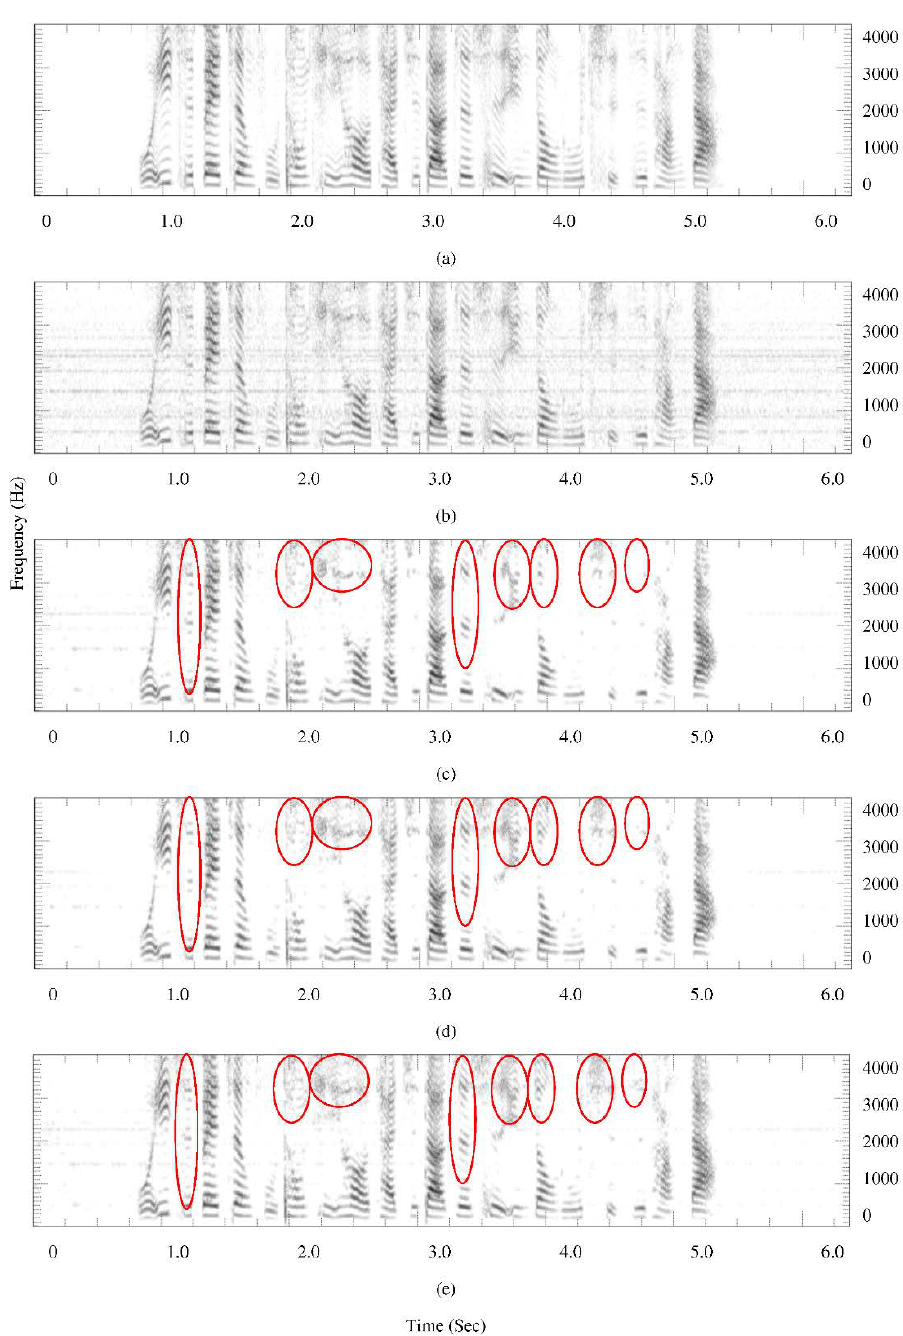
15 of 22 Figure 6. Example of a speech signal spoken in Mandarin Chinese by a female speaker. (From top to bottom) ( a ) clean speech; ( b ) speech interfered by factory noise with an average SegSNR = 5 dB; ( c ) denoised speech using the MCRA noise estimator; ( d ) denoised speech using the forward-backward MCRA noise estimator; ( e ) denoised speech using the proposed noise estimator.